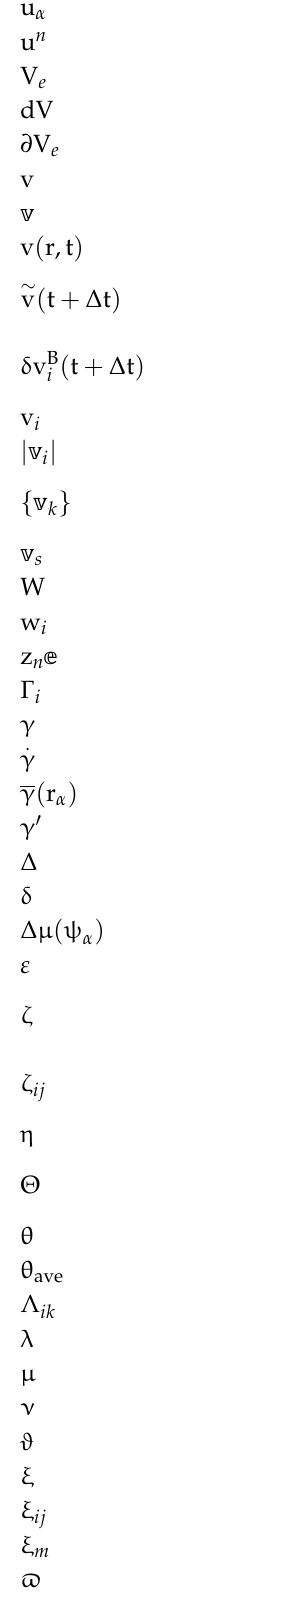
Figure 1. Two typical lattices often used in LB simulations: ( a ) D2Q9; and ( b ) D3Q19.